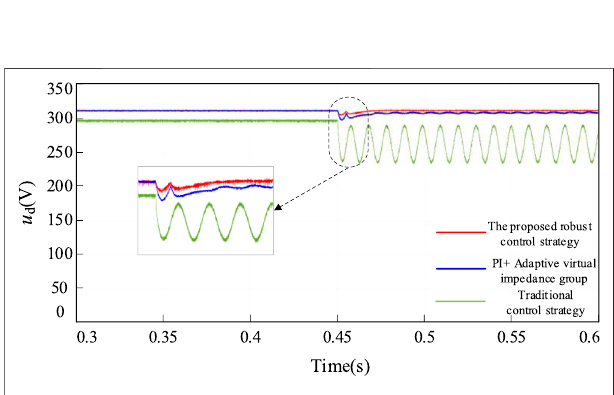
FIGURE 14 | Inverter output voltage d-axis component